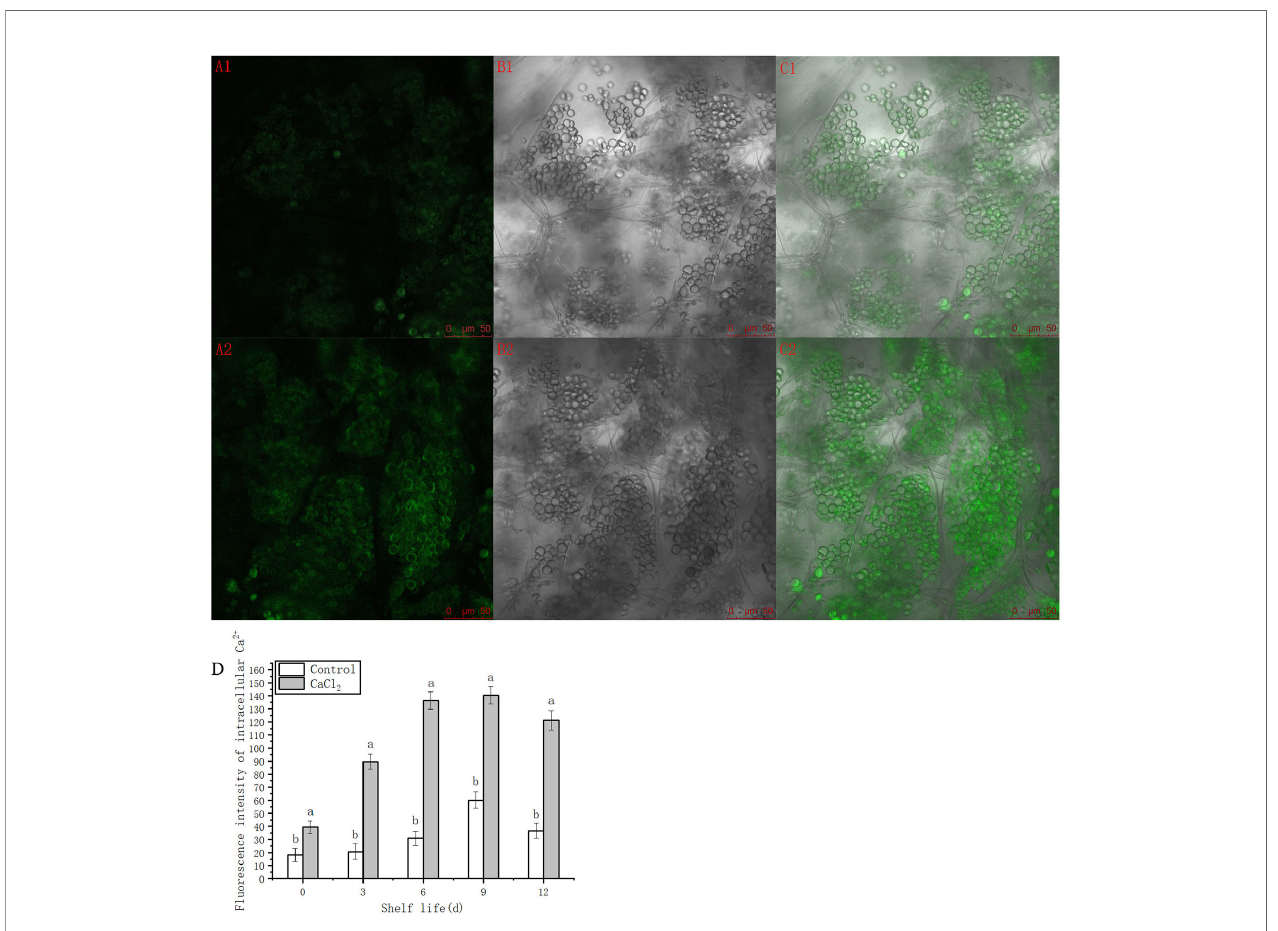
FIGURE 3 | Dynamic change and cytochemical localization of Ca 2+ in refrigerated but untreated (A1, B1, C1) and refrigerated with CaCl 2 -treated (A2, B2, C2) samples in the same magni fi cation. (A) Ca 2+ fl uorescence signal characteristic excited by argon-ion laser sources. (B) ‘ Nanguo ’ pear pericarp structure scanned in transmitted light fi eld. (C) Combination of (A, B) . (D) Semi quanti fi cation of the fl uorescence intensity in ‘ Nanguo ’ pear pericarp during the 0, 3, 6, 9, and 12 days at 20°C after cold storage by ImageJ software. Standard deviation values are given. Values are means ± SE of three independent experiments, and fi ve samples were assessed for each treatment. Means with different letters are signi fi cantly different between the treatments and control ( p <